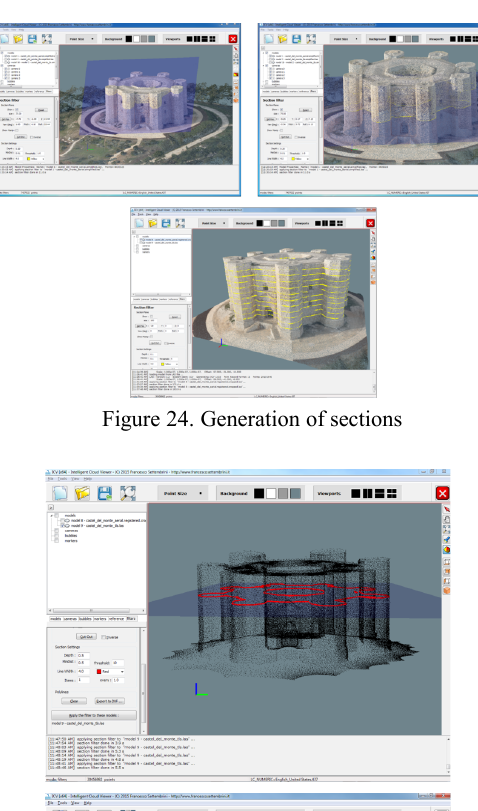
Figure 20. Tools Transformation